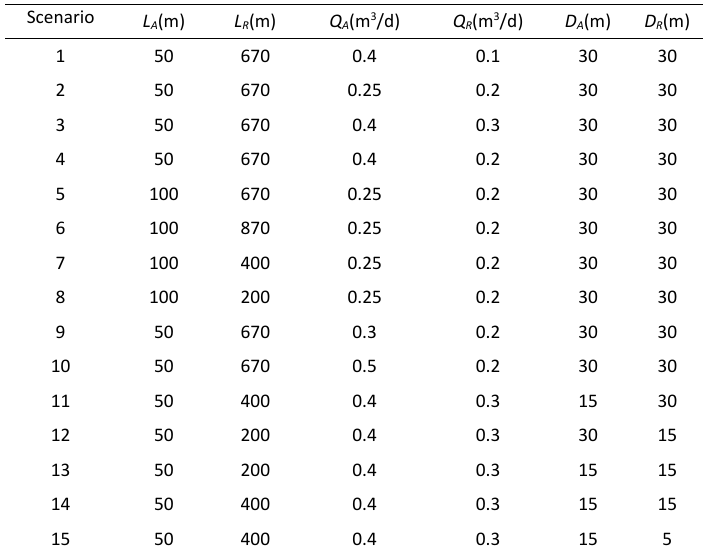
Table 2: Different management scenarios used to evaluate the efficiency of ADR Table 2. Different management scenarios used to evaluate the efficiency of ADR Scenario